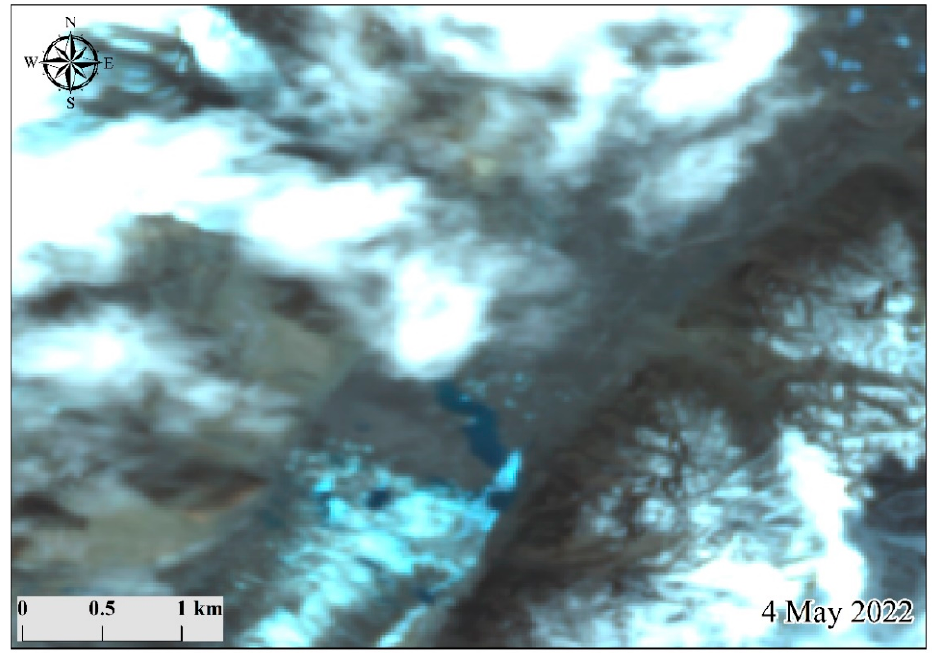
Figure 9. Satellite image of Lake Merzbacher captured in 4 May 2022.